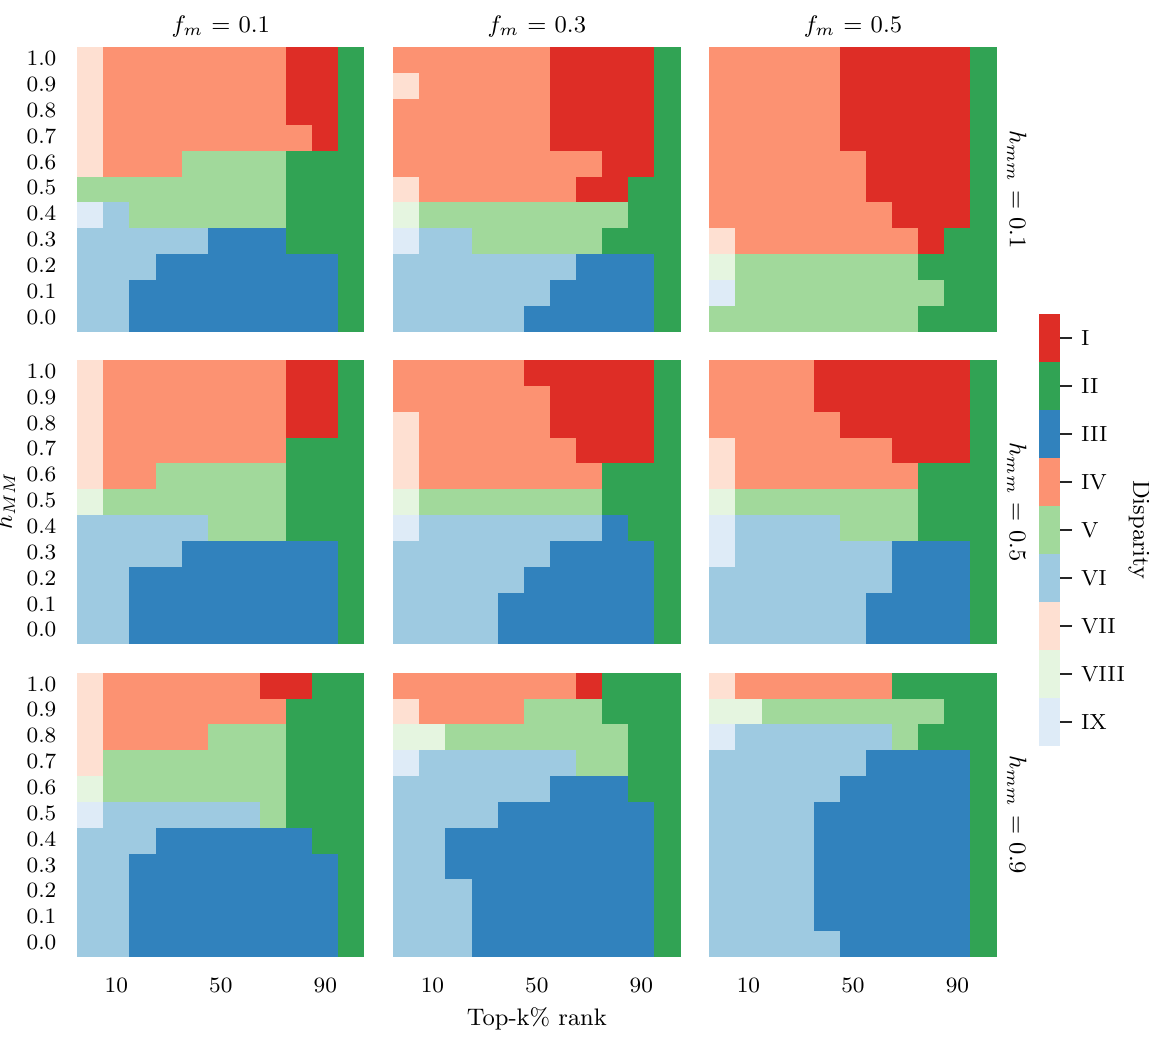
Figure 5. The effects of homophily and fraction of minorities in the local disparity of PageRank. Columns represent the fraction of minorities (10%, 30% and 50%) and rows show homophily within minorities (from top to bottom: heterophilic, neutral and homophilic). The x-axis denotes the top-k% rank and the y-axis shows homophily within majorities. Colors refer to the regions of disparity introduced in Fig. 2. One can see that the minority suffers most (red) when the majority is homophilic and the minority is either heterophilic or neutral. Moreover, inequality is lowest (very light colors) only for a few cases at top-5%. This means that the top best ranked nodes are very similar and their ranks are far from the majority of nodes (i.e., due to preferential attachment). Moreover, inequity remains mostly consistent regardless of top- k %. In other words, if the ranking algorithm favors one group in the top-5% (e.g., red or blue), it will continue to do so until entering the fair regime (green).